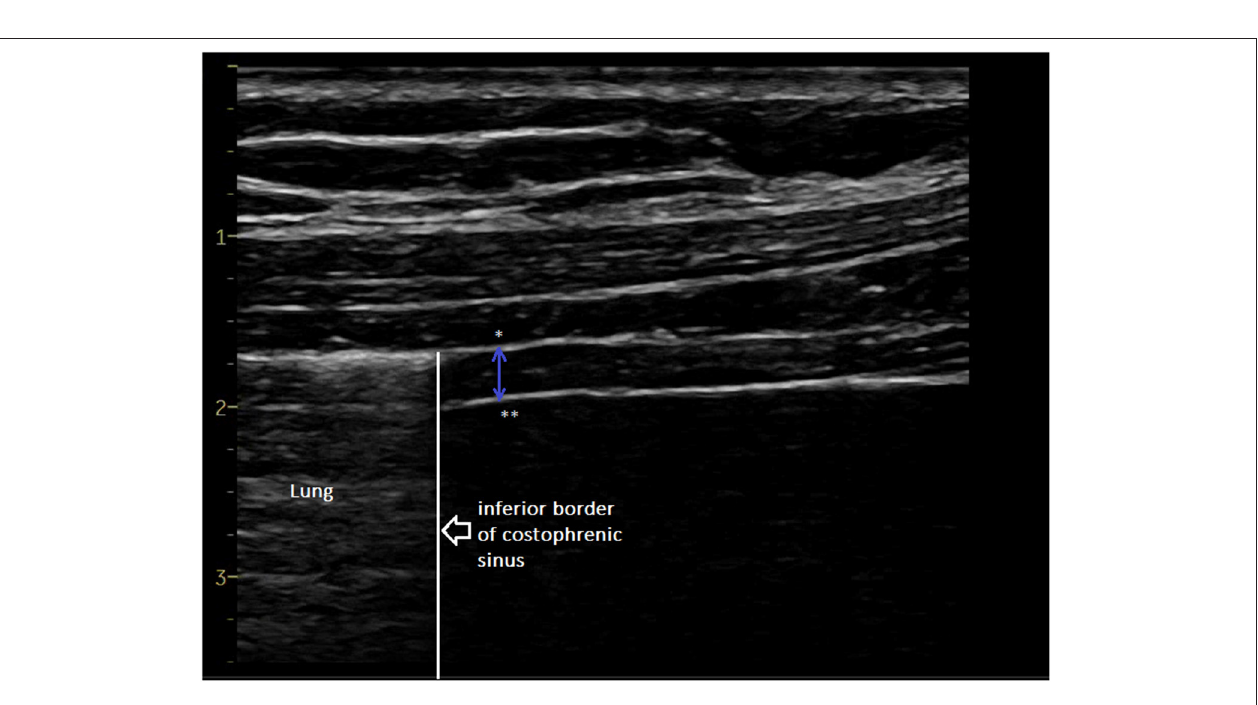
disease, or hemidiaphragm paralysis (1,